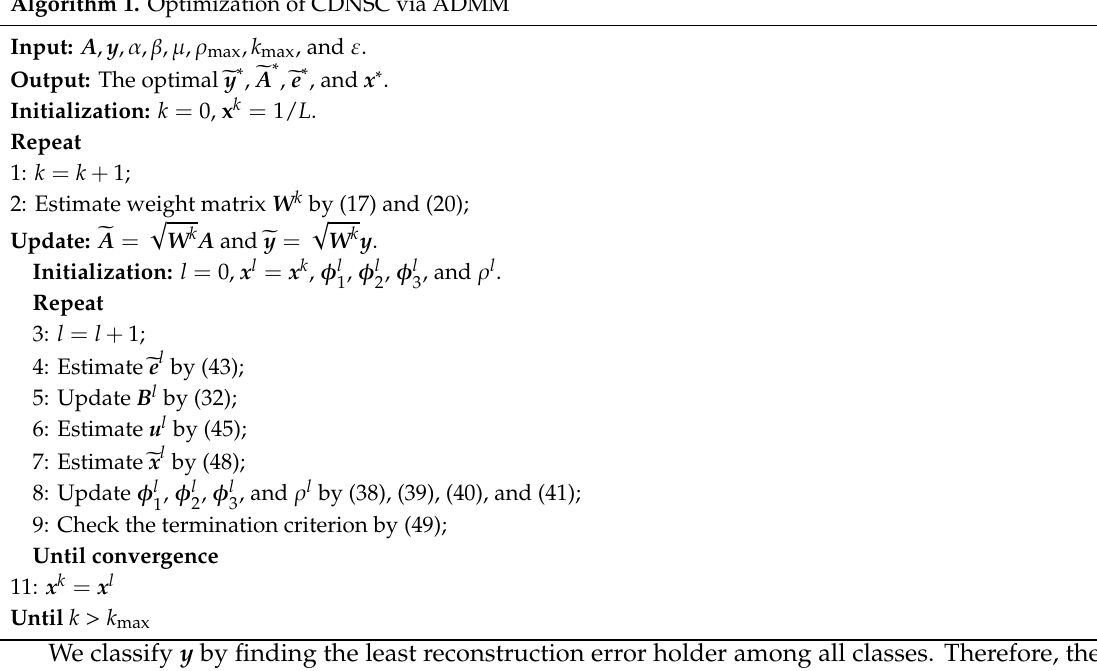
Algorithm 1. Optimization of CDNSC via